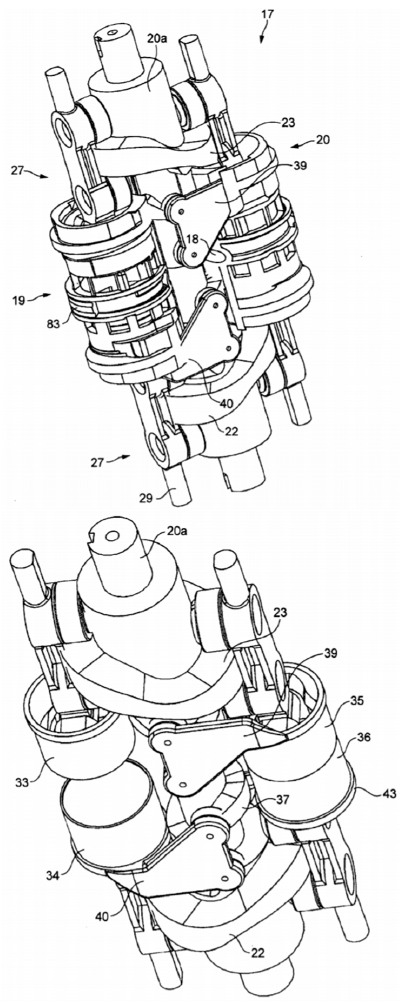
Figure 22. P. Ellis 12 January 2017, sleeve valve engine US 2017/009617A1. Reproduced with